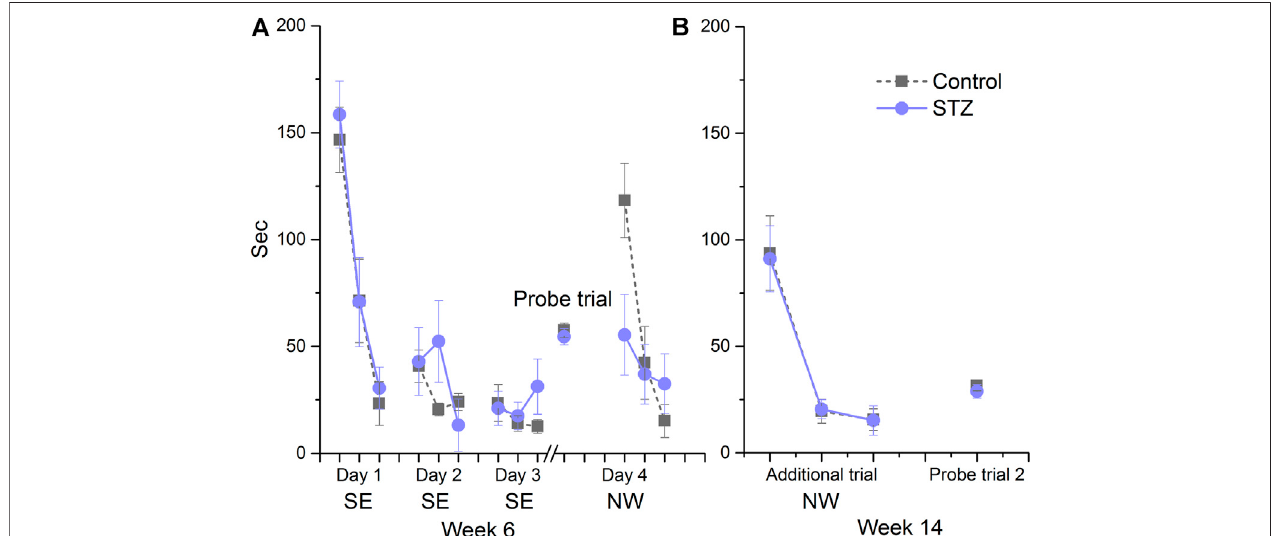
FIGURE 5 | Learning performance in the Morris water-maze in EXP2. Means ± SEM of escape latency values are shown except in the probe trial where the time spent in the target quadrant is depicted. SE and NW indicate the position of the escape platform. (A) There was no signi fi cant difference between groups in the acquisitiontrialsondays1,2and3(Dayxtrial × treatmentinteraction:F (4,88) (cid:2) 1.80,ns)intheprobetrial(unpaired t -test: t (22) (cid:2) 0.58,ns))andduringthere-acquisitionat day 4 (Day × treatment interaction: F (2,44) (cid:2) 3.79, ns). (B) No signi fi cant difference was detected during the additional acquisition session (Day × treatment interaction: F (2,44) (cid:2) 0.01, ns) and the second probe trial (unpaired t -test: t (22) (cid:2) 0.66, ns).